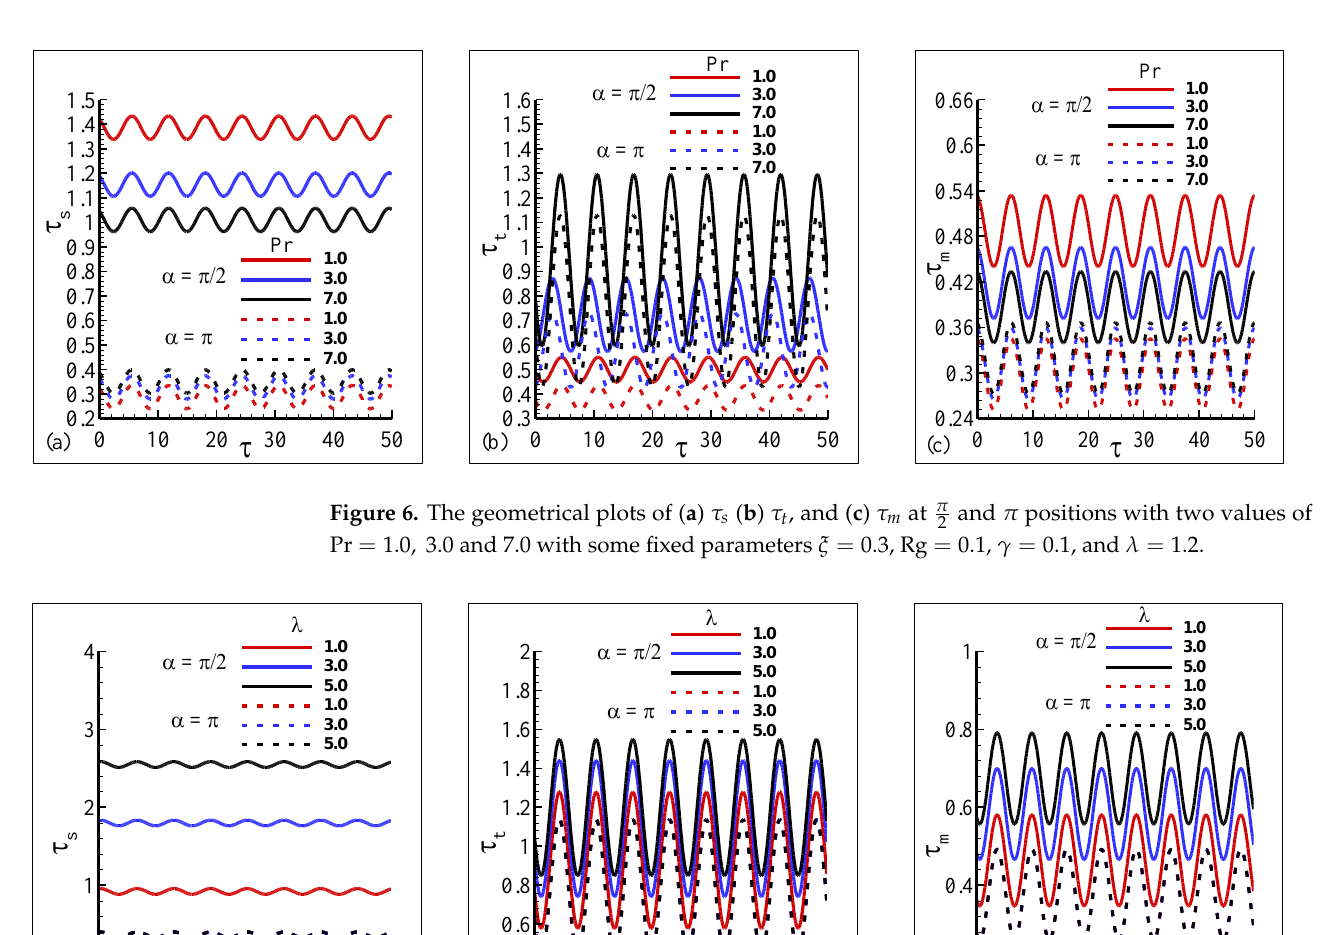
Table 1. The numerical results of skinfriction for various choices of magnetic Prandtl parameter γ = 1.0, 10.0, 100.0, for ξ = 0.8 at the leading edge α = 0.0. γ Mehmood et al. [29] Ilyas et al.